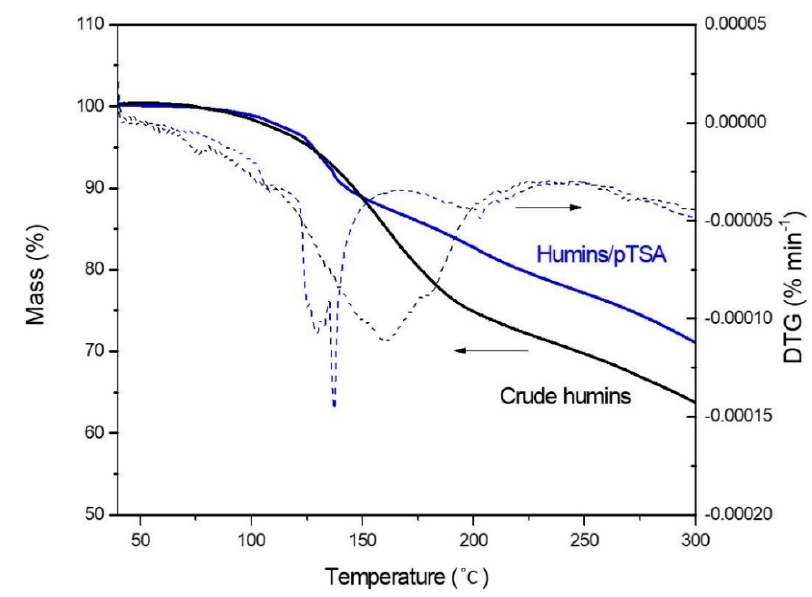
Figure 8. TG and DTG measurement of crude humins and humins/pTSA, heating rate 2 °C min − 1 under air.